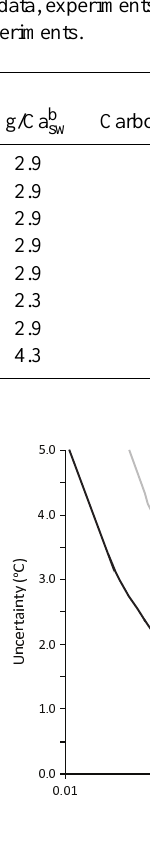
Fig. 4. Temperature uncertainty caused by variability in salin- ity (1), Mg/Ca SW (0.6molmol − 1 ) and carbonate ion concentration (50µmolkg − 1 ). Temperature uncertainties are calculated at 8 ◦ C using the Mg/Ca–temperature calibration for B. marginata with a changing temperature sensitivity (exponential constant). Tem- perature sensitivities used for the different species are from Ta- ble 4. Mg/Ca parameter relations from a number of studies were used to calculate the uncertainty in temperature. Mg/Ca SW : Wit et al. (2012). Salinity: Due ˜ nas-Boh ´ orquez et al. (2009). Carbonate ion concentration: Due˜nas-Boh´orquez et al.